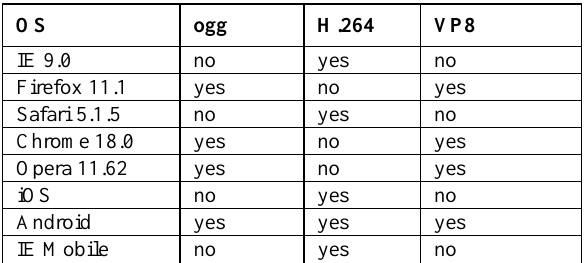
Table 2: Native video codec support by browser